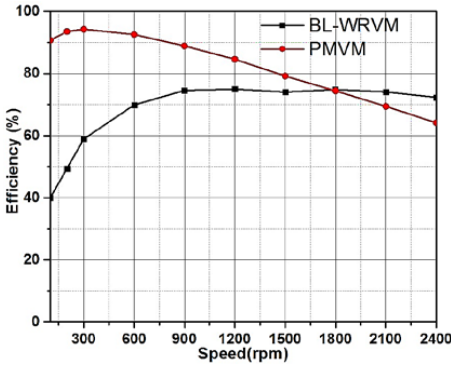
Figure 16. Efficiency comparison of the BL-WRVM and PMVM.